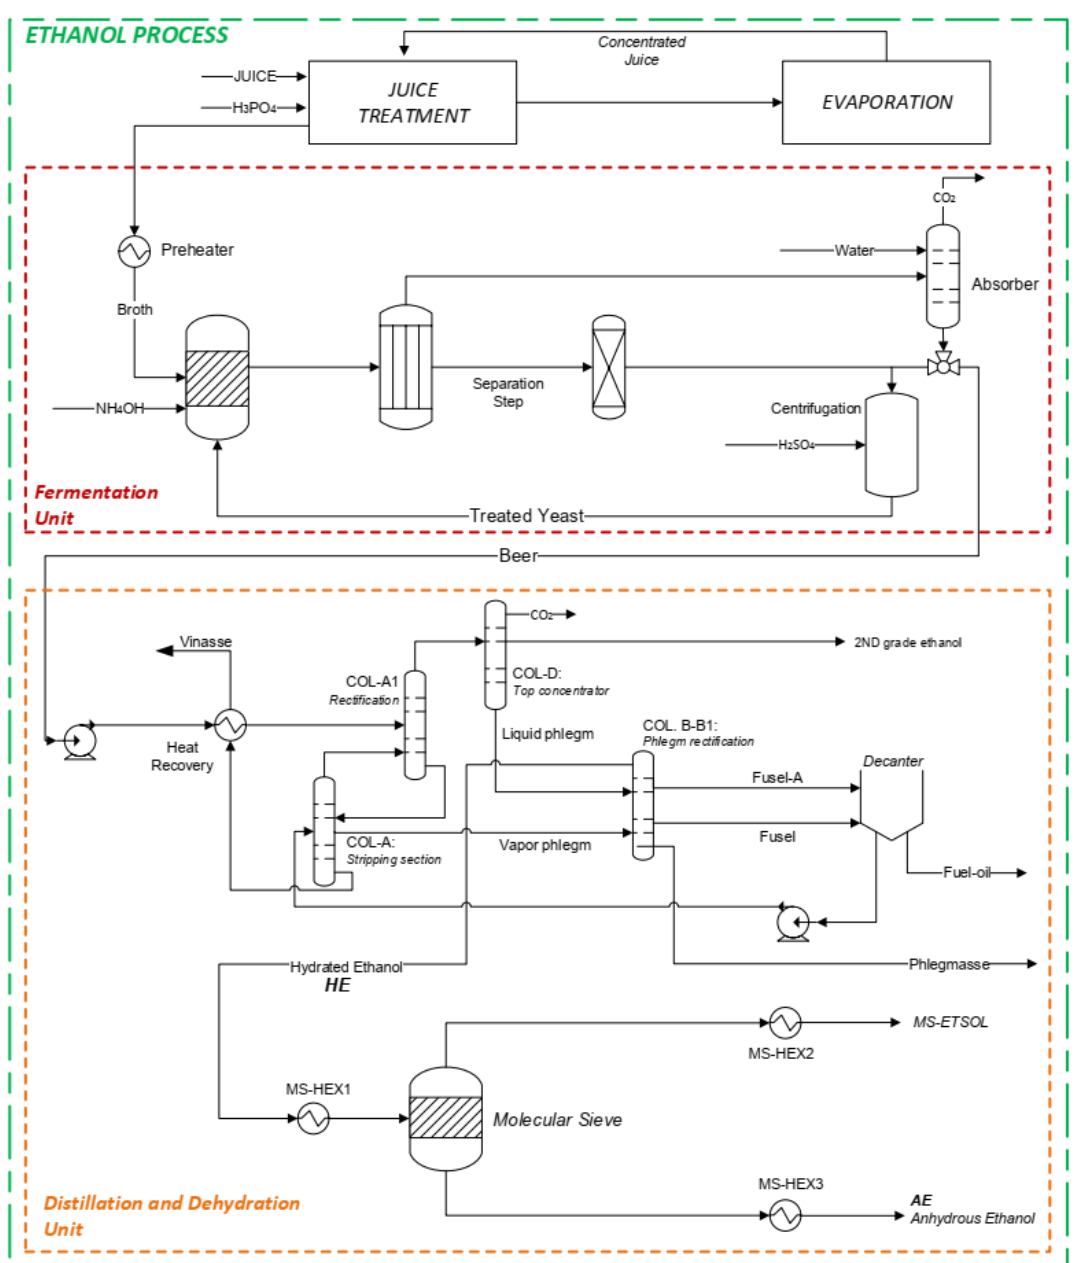
Figure A1. Flow diagram of the ethanol production process.